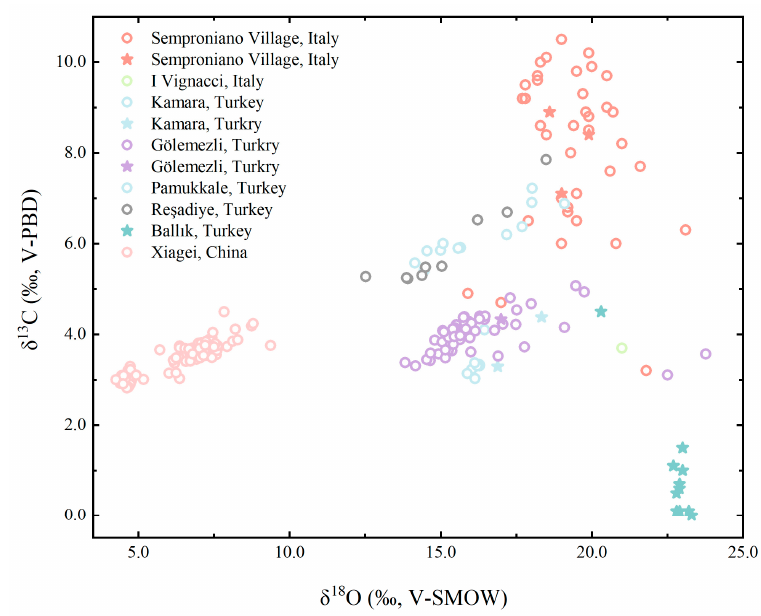
Figure 7. δ 13 C and δ 18 O values of banded calcite veins from Xiagei and those from other examples.